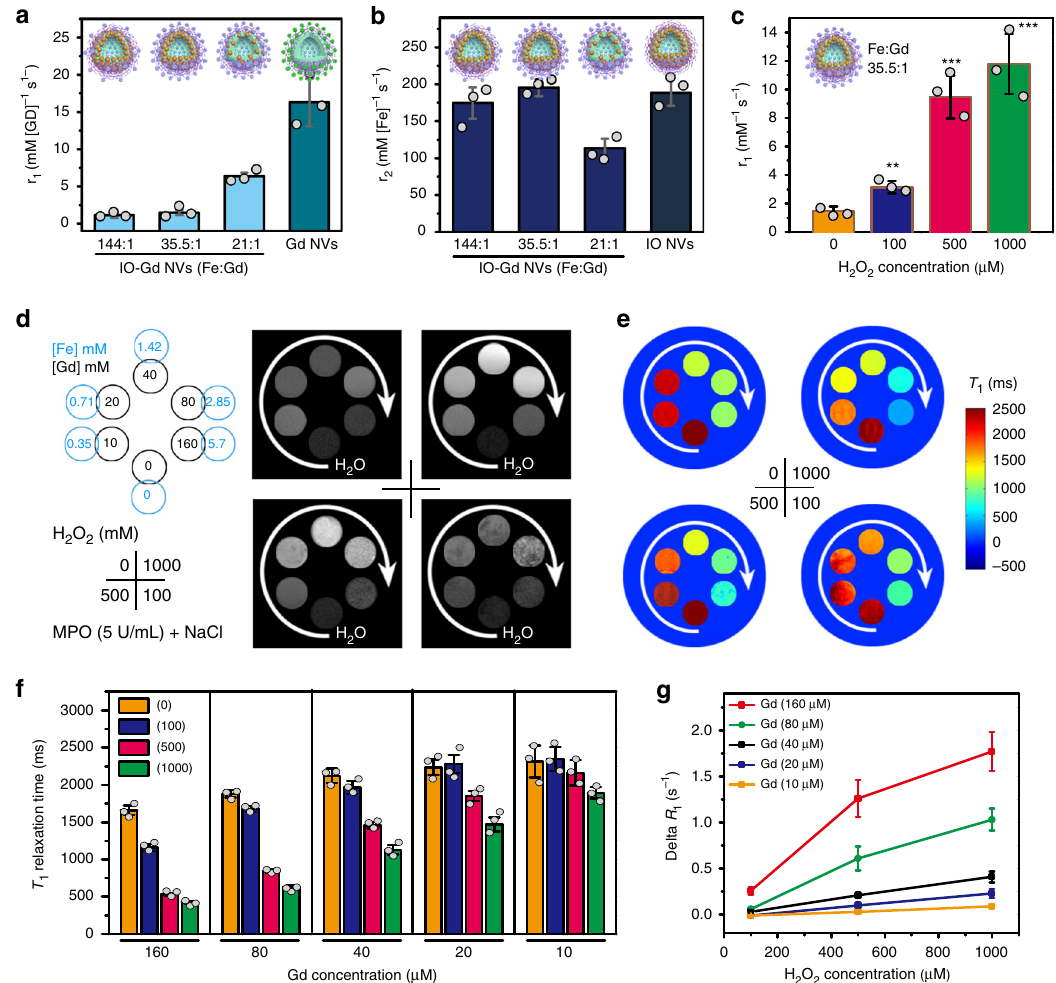
Fig. 3 MRI measurements of the IO-Gd NVs. a , b The r 1 and r 2 values of the IO-Gd NVs with different Fe:Gd ratios, compared with Gd NVs and IO NVs, respectively. The r 1 and r 2 values were calculated on the basis of Gd and Fe elements for the IO-Gd samples, respectively. c , d The r 1 values and T 1 phantom images of the IO-Gd NVs (Fe:Gd = 35.5:1) incubated with different concentrations of H 2 O 2 (0, 100, 500, and 1000 μ M, lower right) in the presence of same amount of NaCl and MPO (5 U/mL). White arrows indicate the sample concentrations from low to high (d, upper left). MRI phantom acquisition parameters are TR = 500 ms and TE = 12.5 ms. ** P = 0.0016; *** P < 0.001 ( n = 3 independent samples, one-tailed paired t -test). e , The quantitative T 1 relaxation time maps reconstructed from multiple T 1 phantom images with TR = 50, 250, 500, 1000, 2000, 4000, 6000 ms, and TE = 12.5 ms. f Columns show the T 1 relaxation times of the IO-Gd NVs at different conditions ( n = 3 independent samples). g Analysis of the Δ R 1 (1/ T 1 ) of the IO-Gd NVs at different conditions ( n = 3 independent samples). All error bars indicate mean ±